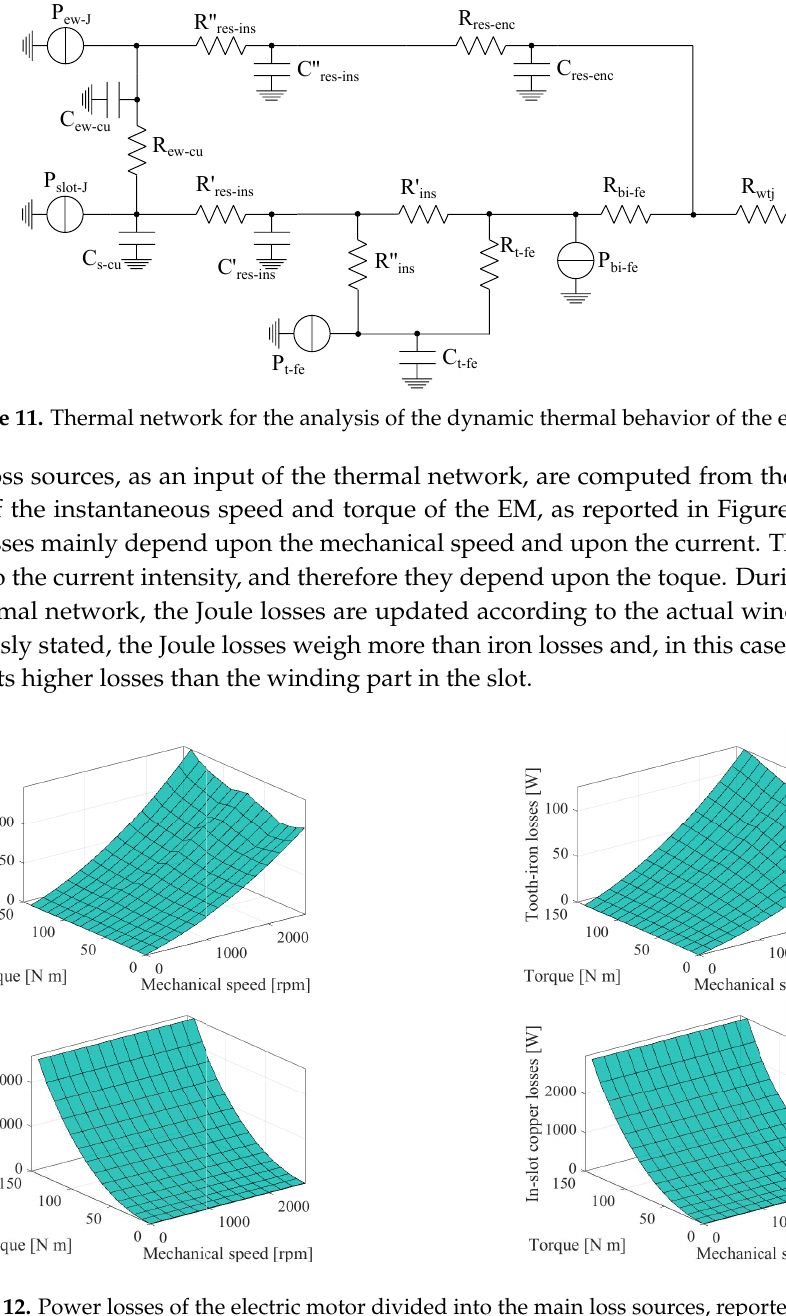
Figure 12. Power losses of the electric motor divided into the main loss sources, reported as a function of the mechanical speed and